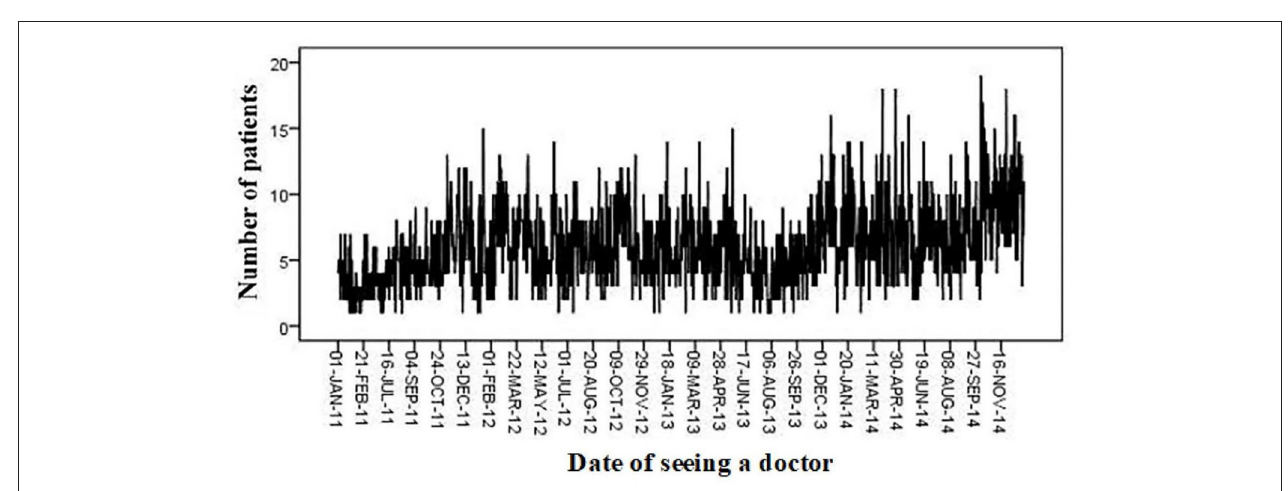
FIGURE 2 | Number of patients with atrial fibrillation seen in emergency departments per day, 2011–2014.